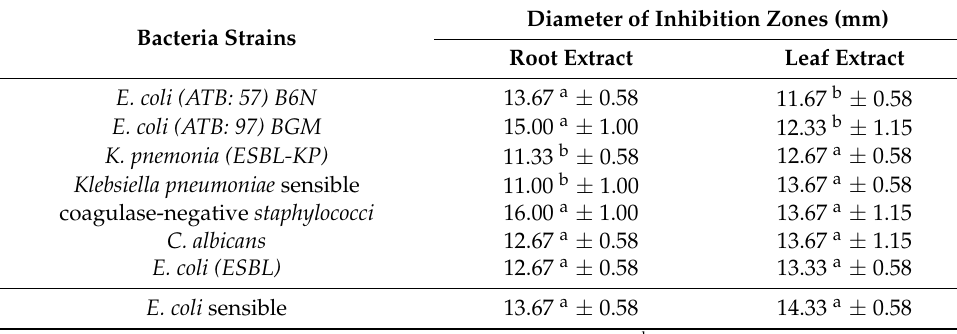
Table 5. The minimum inhibitory concentration (MIC) of Anchusa italica Retz extracts. Bacteria